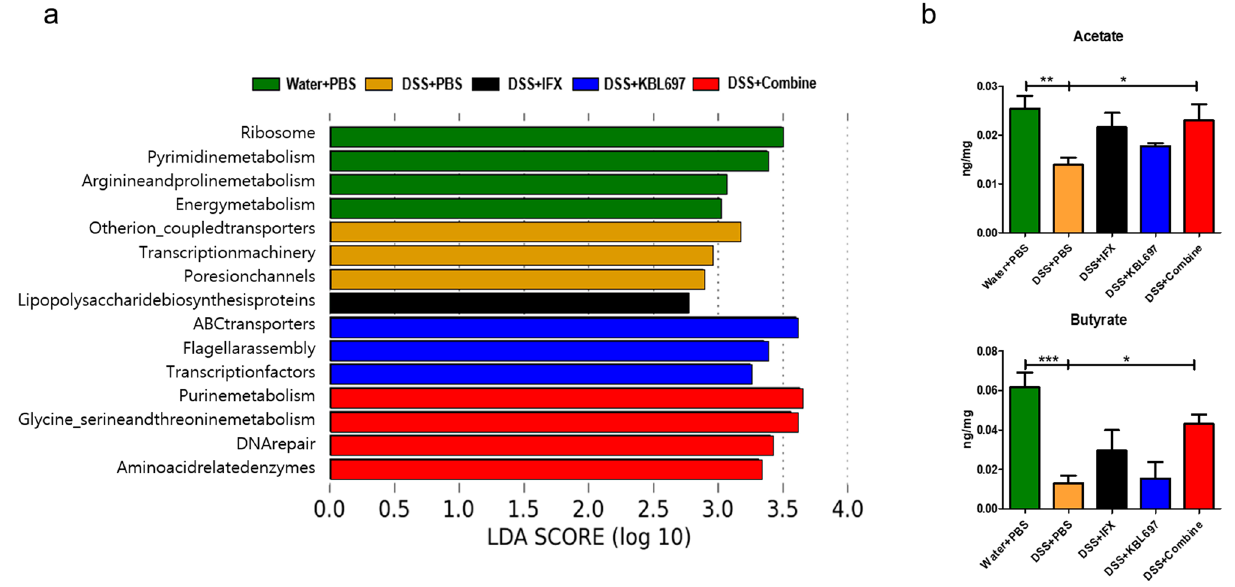
Figure 6. Differences in profiles of functional alteration related to cecal microbiota and SCFAs via the different treatments. ( a ) PICRUSt results in experimental groups (threshold > 2.5). ( b ) Acetate and butyrate levels. When appropriate, statistical analysis was performed using one-way ANOVA with Dunnett’s post hoc test (* P < 0.05; ** P < 0.01; *** P <